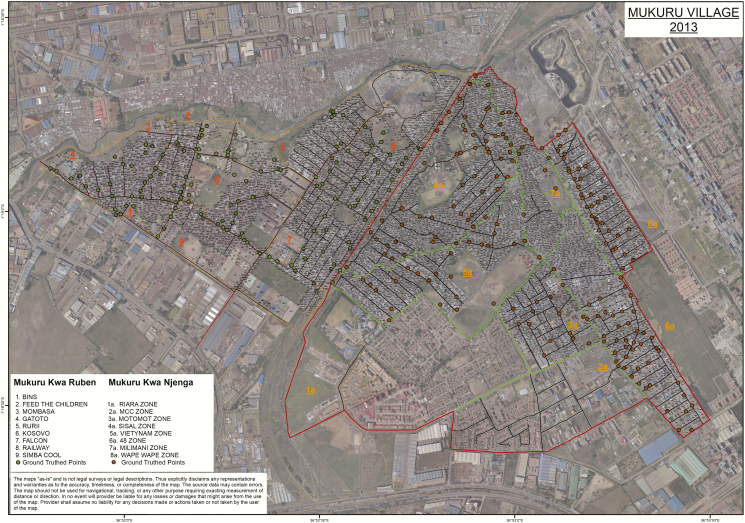
Demographic and disease surveillance site in the Mukuru informal settlement.The 2 villages where households were mapped (Mukuru kwa Ruben and Mukuru kwa Njenga) and a census was done are shown as darkened dots, and the numbers show the respective zones (zones 1–9 for Mukuru kwa Ruben and 1a to 8a for Mukuru kwa Njenga) for each village.